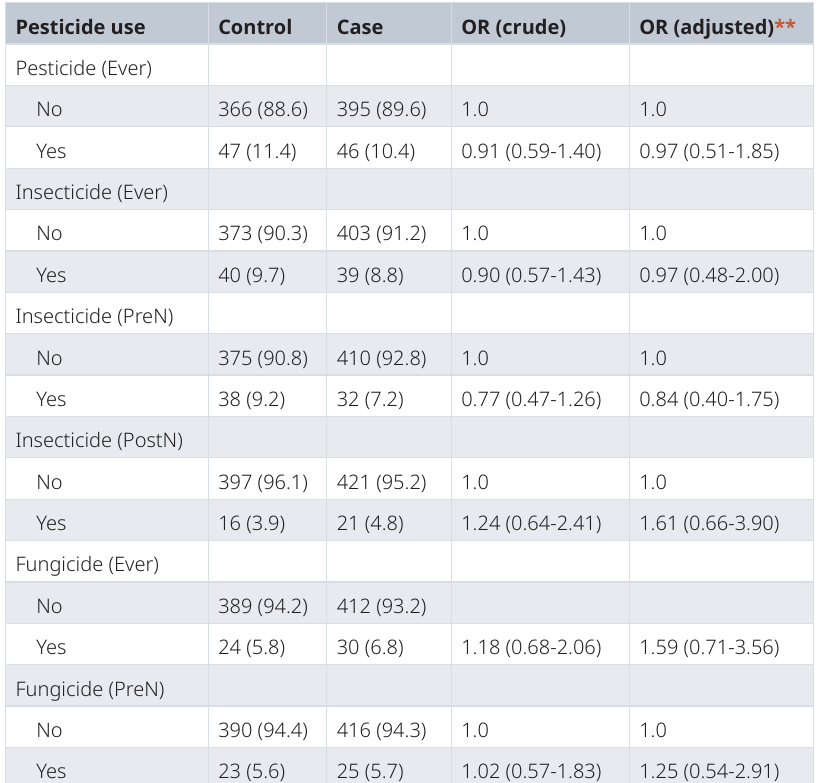
Table 2. Types of pesticides exposure of case and control and risk of suspected developmental